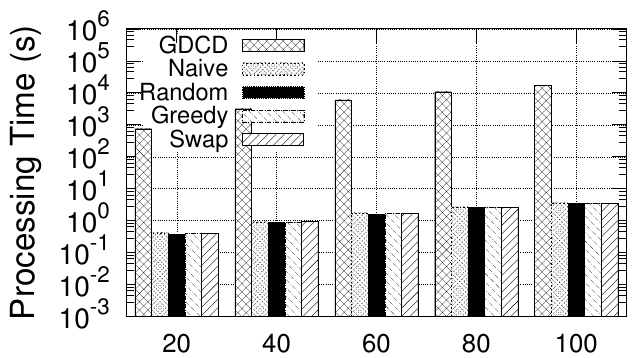
Figure 13. (Eval-IX) Scalability testing (vary | V |